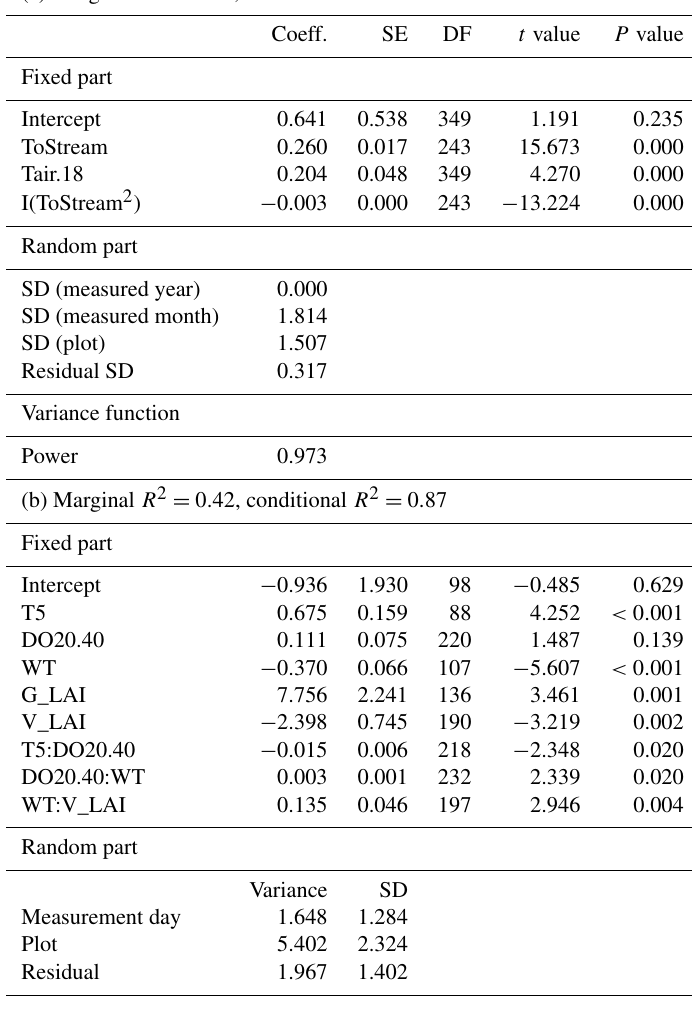
Table A3. Parameter estimates of the linear mixed-effect models describing the response of methane (CH 4 ) fluxes to environmental variables in the (a) 2017–2019 and (b) 2019 datasets. ToStream: the distance from the plot to the stream; Tair.18: air temperature greater than the threshold value of 18 ◦ C; T5: peat temperature at 5cm depth below the surface; DO20.40: dissolved oxygen concentration at 20cm depth below the surface which is lower than the threshold value of 40%; WT: water level relative to the moss surface; G_LAI: graminoid LAI; V_LAI: vascular